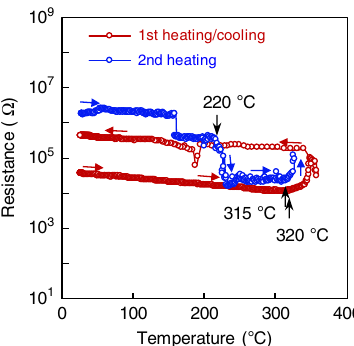
Fig. 4 Temperature dependence of resistance in the MnTe device. The initial state of the device was a low resistance state with an α -phase. The MnTe device was annealed up to about 359 °C and then cooled to room temperature (RT) ( fi rst heating/cooling cycle). The MnTe device was reheated up to 335 °C (second heating). The step decrease in resistance at around 160 °C in the second heating is due to the experimental error caused when the measuring range is switched from 10 6 to 10